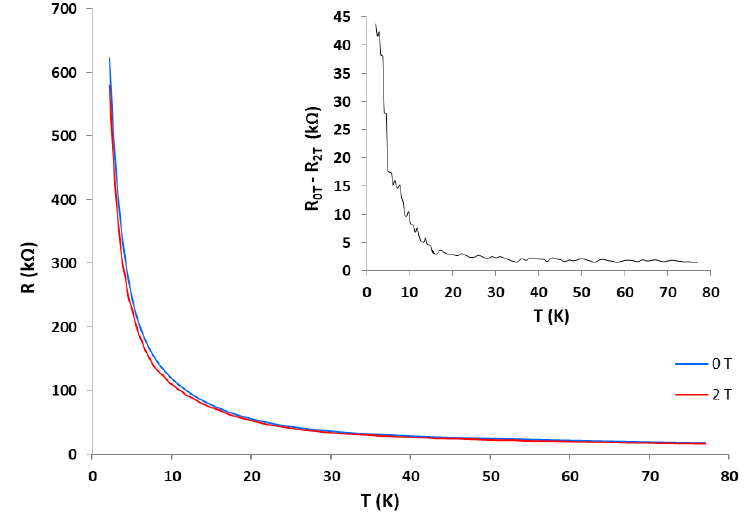
Figure 9. Resistance vs. Temperature curves for Sensor 1 at a magnetic field B = 0 and 2 T. The inset shows the difference of the resistance measured at B = 0 and 2 T.